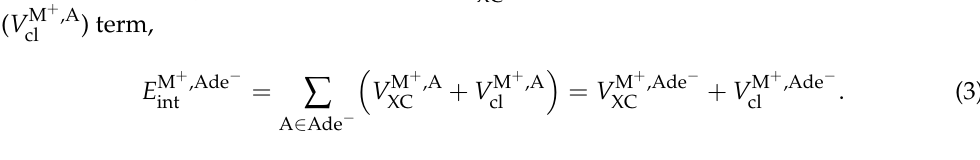
+ ,Ade − and its covalent V M int